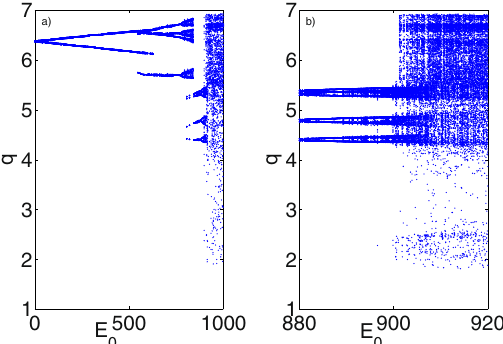
Figure 2. Bifurcation diagram of mechanical displacement q with varying E 0 . ( a ) is with a large E 0 varying range and ( b ) is with an narrower range extracted from ( a